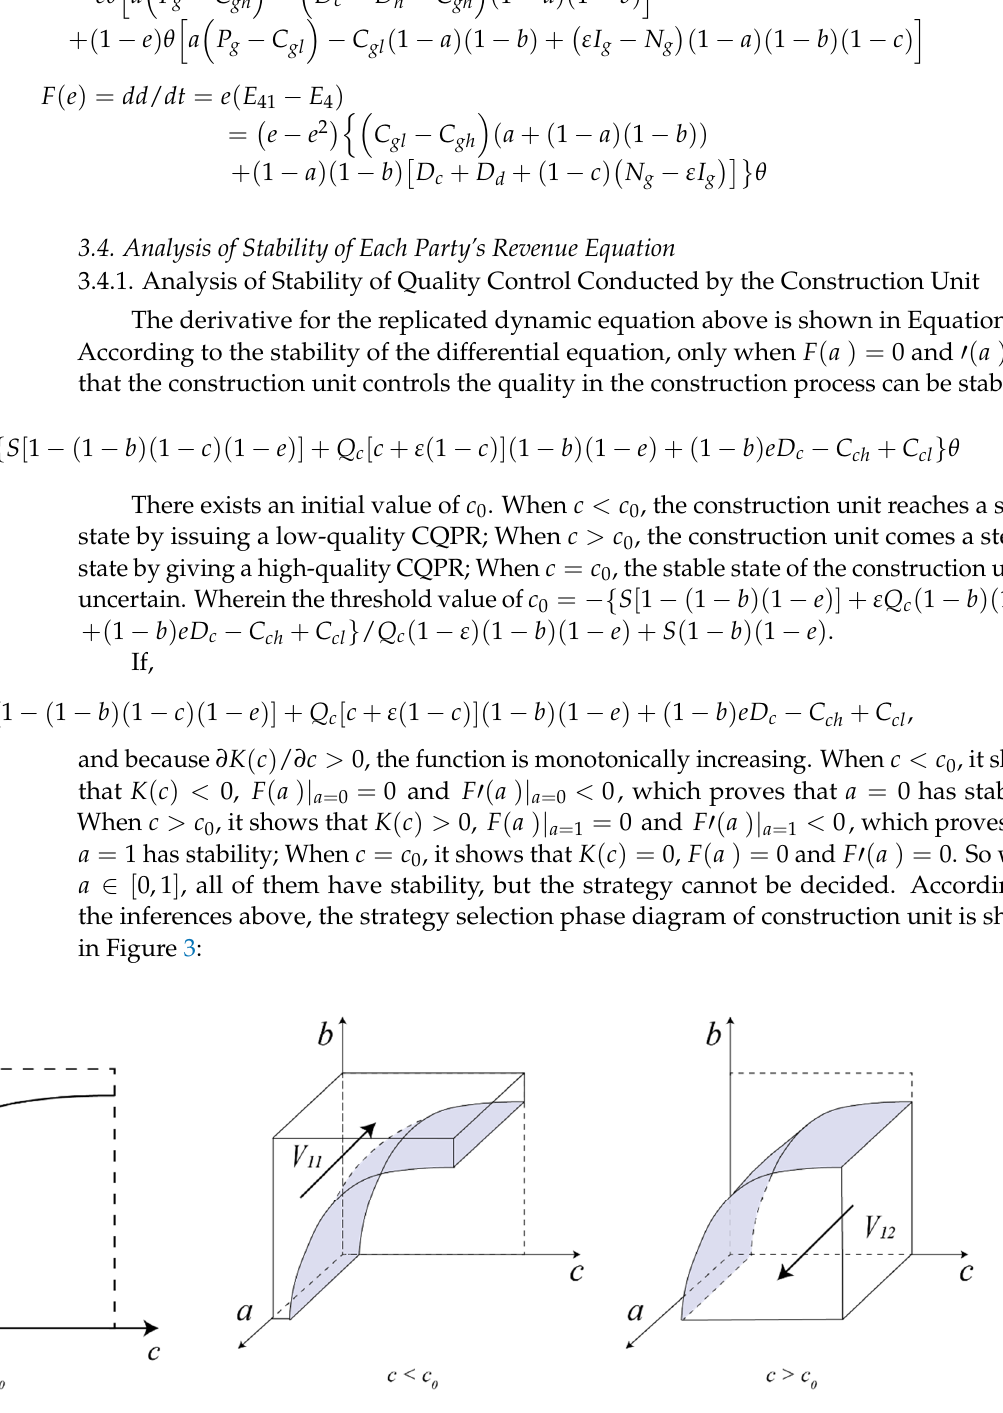
Figure 3. Strategy selection phase diagram of construction unit.